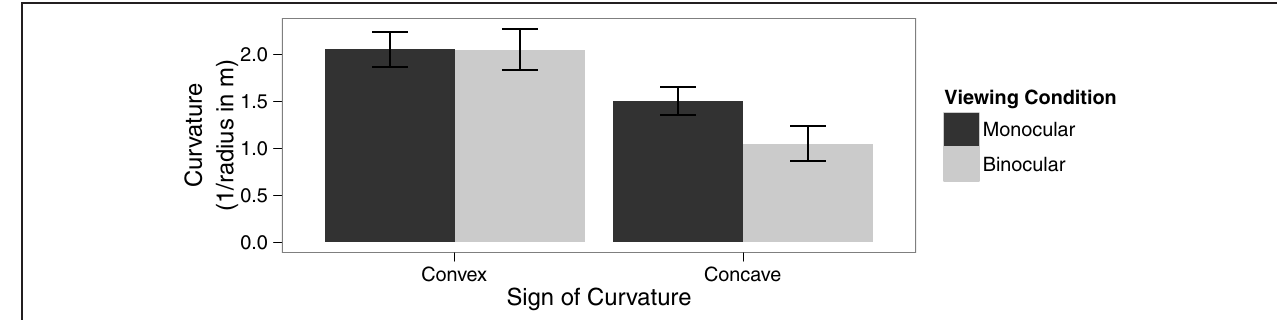
FIGURE 2 | Means in each condition with error bars representing ± 1 between-subjects standard error of the